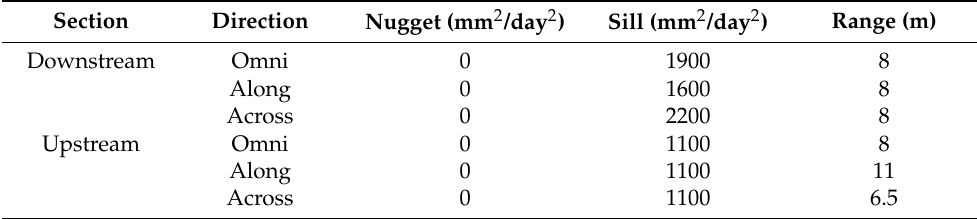
Figure 5. Variograms and fitted variogram models for the downstream section ( a ) omnidirectional and ( b ) directional and for the upstream section ( c ) omnidirectional and ( d ) directional. Directional variograms are calculated across and along the river. Table 2. Summary of parameters of the variogram models of estimated exchange flux for the upstream and downstream sections.